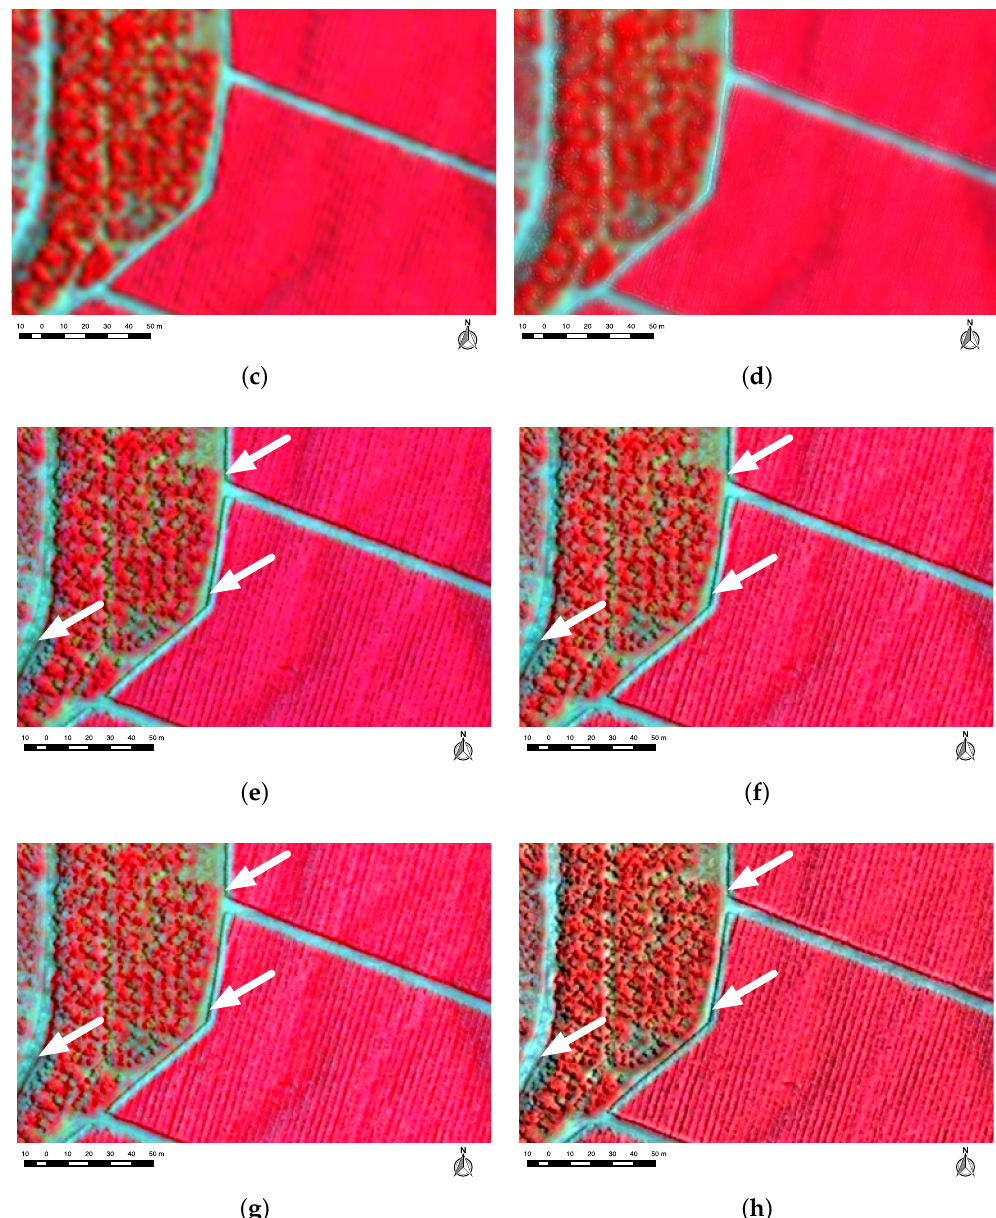
Figure 9. Specific analysis site of QB Agricultural. ( a ) MS image; ( b ) PAN image; ( c ) PSRGF E pansharpened image; ( d ) WATFRAC pansharpened image; ( e ) BT pansharpened image; ( f ) GS pansharpened image; ( g ) IHS pansharpened image; ( h ) MTF–GLP pansharpened